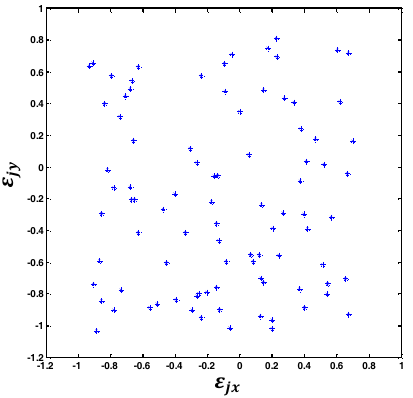
Figure 7. The variation tendency of regression error (cid:1831) (cid:1804) with respect to the equal increase of (cid:1838) . ( a ) The number of sample is 900. ( b )The number of sample is 450. ( c ) The number of sample is 300.